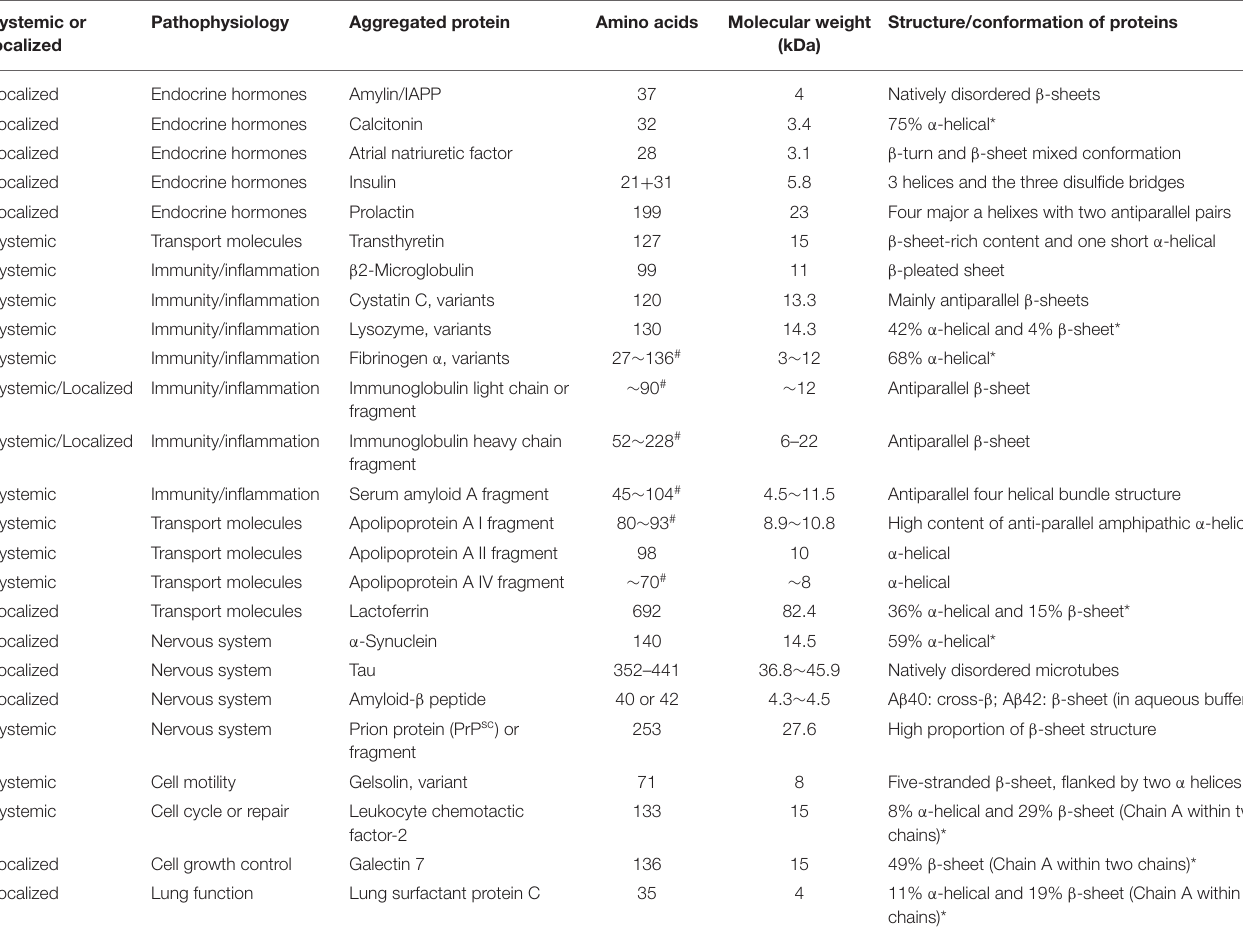
TABLE 1 | Distinct structures of common amyloid proteins in clinical conditions. Systemic or